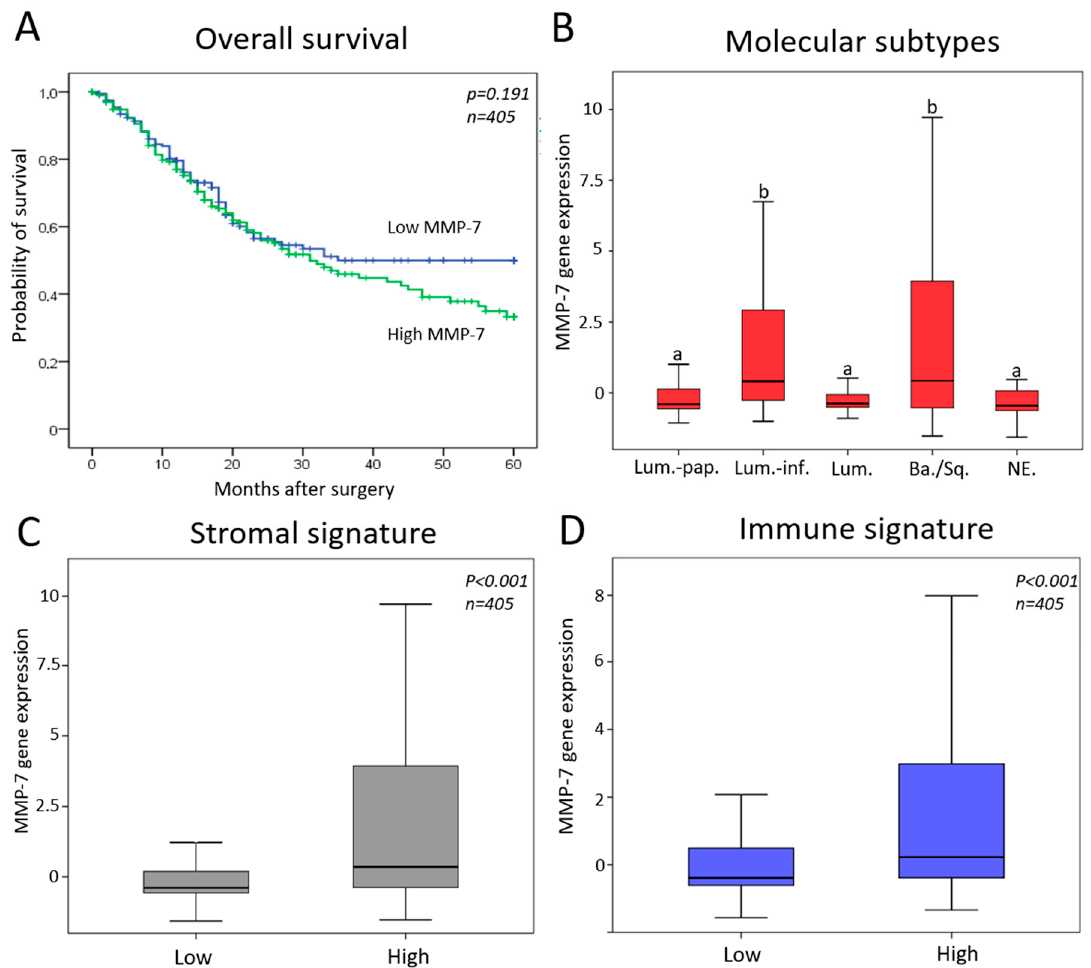
Figure 4. MMP-7 gene expression in the TCGA cohort ( A ) Kaplan–Meier plots for patients’ overall survival with low ( n = 203) and high ( n = 202) MMP-7 expression. ( B ) MMP-7 gene expression was significantly associated with TCGA II subtypes. Various letters present significant differences ( p < 0.001). Molecular subtypes signed with “a” have significantly lower MMP-7 expression, as compared to subtypes signed with “b”. ( C ) MMP-7 gene expression was significantly higher in samples with a high stromal signature score. ( D ) MMP-7 gene expression was significantly higher in samples with a high immune signature score. MMP-7 gene expression levels were normalized to TBP, according to the Δ Ct method. Lum.-pap.—luminal-papillary, Lum.-Inf.—luminal-infiltrated, Lum.—luminal, Ba./Sq.—Basal/Squamous, Ne.—Neuronal subtypes.